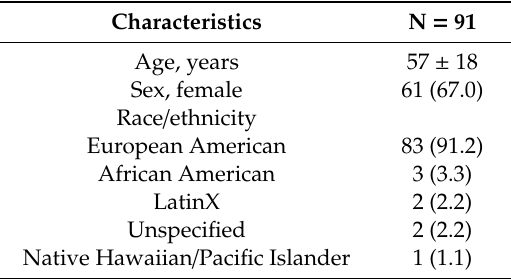
Table 3. Characteristics of the pharmacogenetics consult clinic patients.